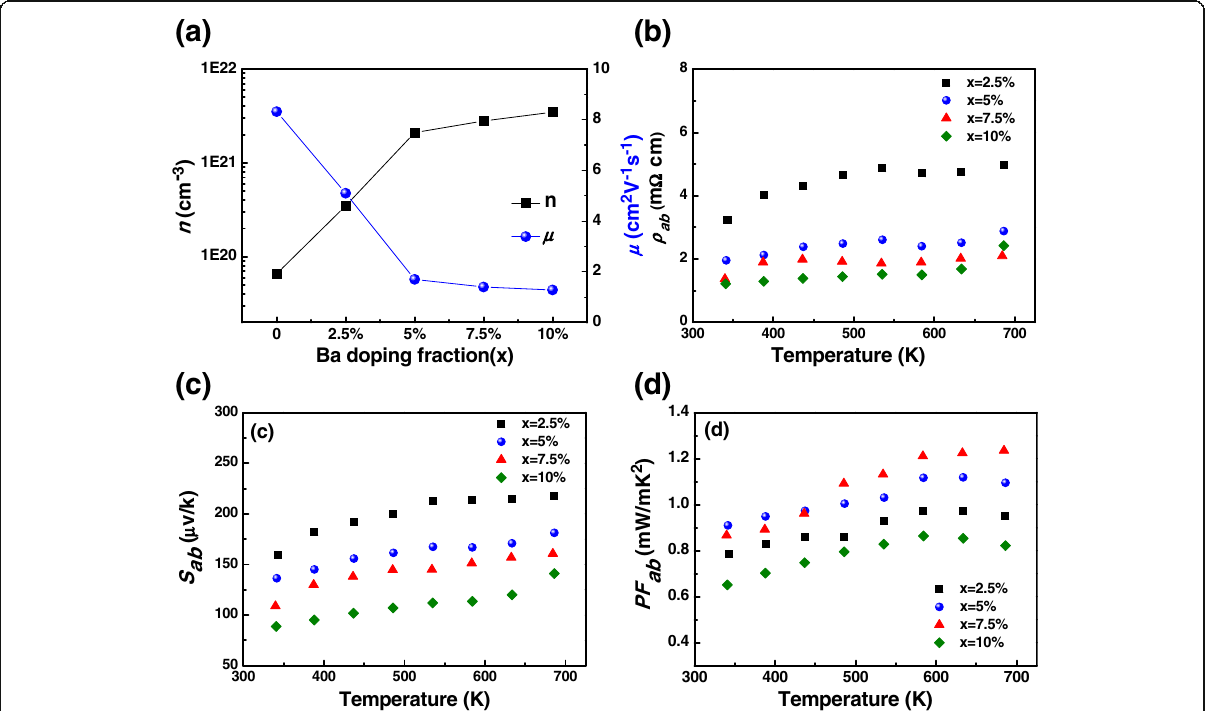
Fig. 4 a Carrier concentration n and mobility μ of the Bi 1 − x Ba x CuSeO (0 ≤ x ≤ 10%) thin films measured at room temperature. b The temperature dependence of the ab plane resistivity ρ ab . c Seebeck coefficient S ab . d Power factor PF ab of the Bi 1 − x Ba x CuSeO (0 ≤ x ≤ 10%) thin